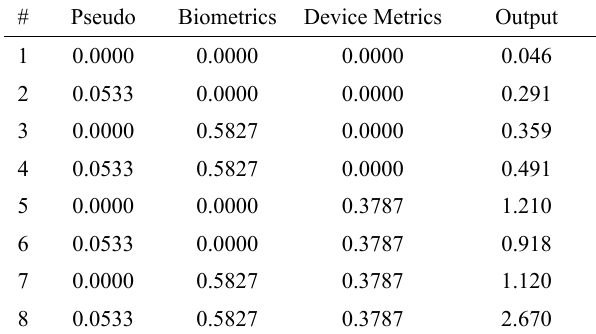
Table 10: Input values and the corresponding output values generated by the FIS information fusion technique using entropy identity attributes metrics values.